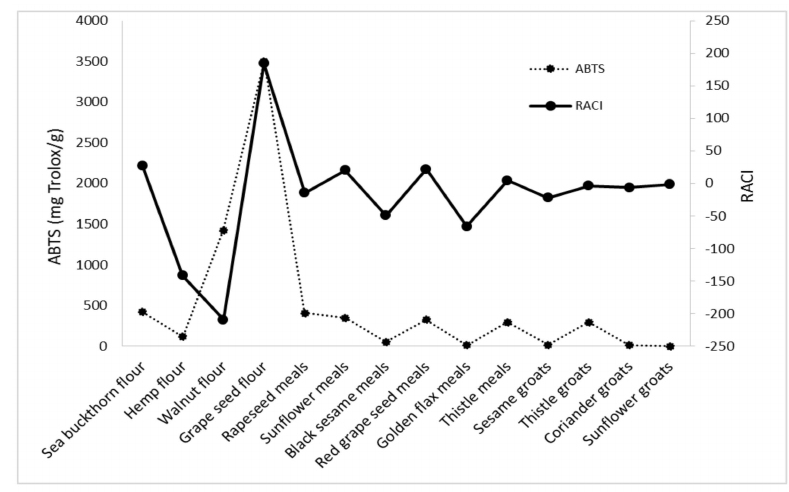
Figure 7. Correlation between RACI and ABTS activity.